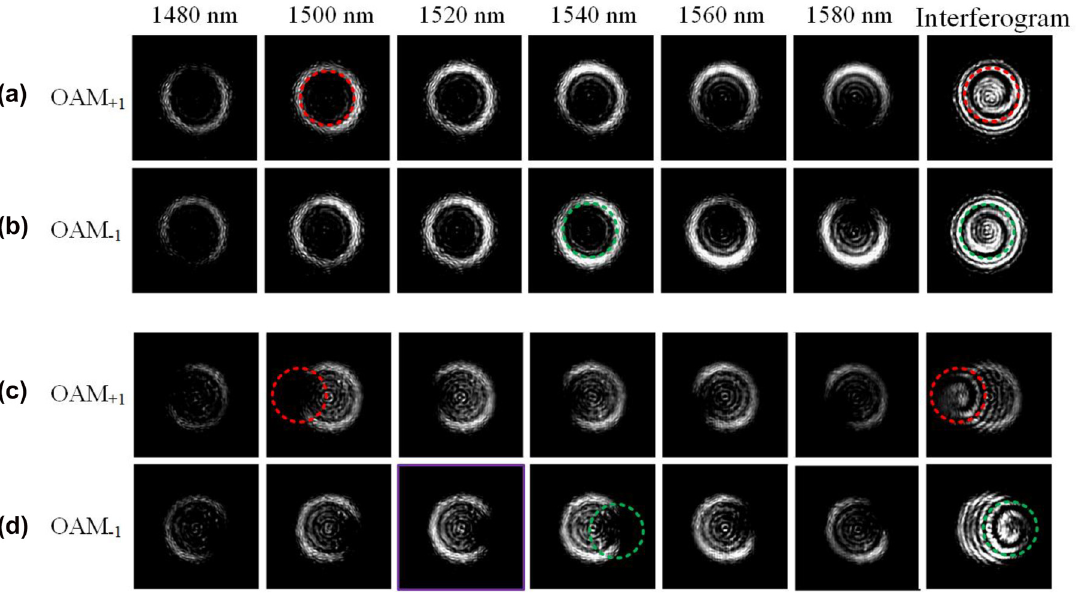
Figure 10: Measured far-field intensity profiles and interferograms for (a, b) conventional subwavelength holographic surface fork grating and (c, d) tilt subwavelength holographic surface fork grating. Table 1: Comparison of the reported